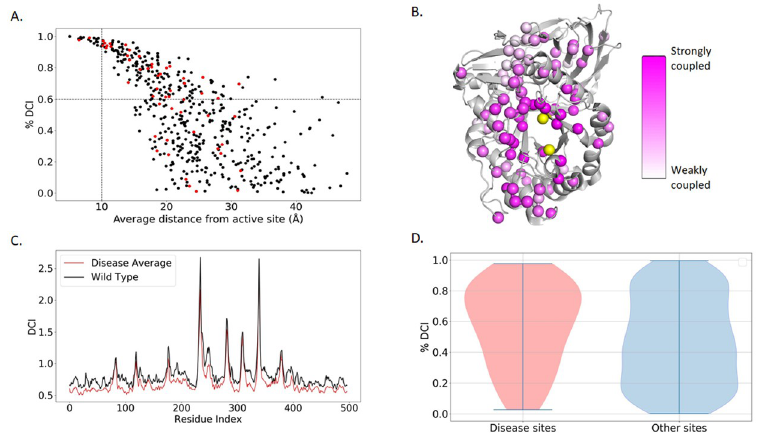
Fig 3. DCI of GCase sites. ( a ) Scatter plot of all GCase residues with dividers at %DCI = 60 and distance = 10 Å . The upper right quadrant contains DARC sites which can affect the active site without direct interaction. Red dots indicate severe DAVs, which have a significantly higher DCI ( P < .001) than other sites. ( b ) A ribbon diagram showing known mutation sites of GCase (represented as pink-colored dots) and the degree of coupling to the active site delineated by the color gradient, where darker and lighter shades correspond to strongly coupled and weakly coupled, respectively. ( c ) Average DCI profile of 20 different DAVs compared to the wild-type. In general, we observe a global loss of coupling to the active site. ( d ) Violin plots showing that DAVs are generally located at sites that have higher DCI with the active